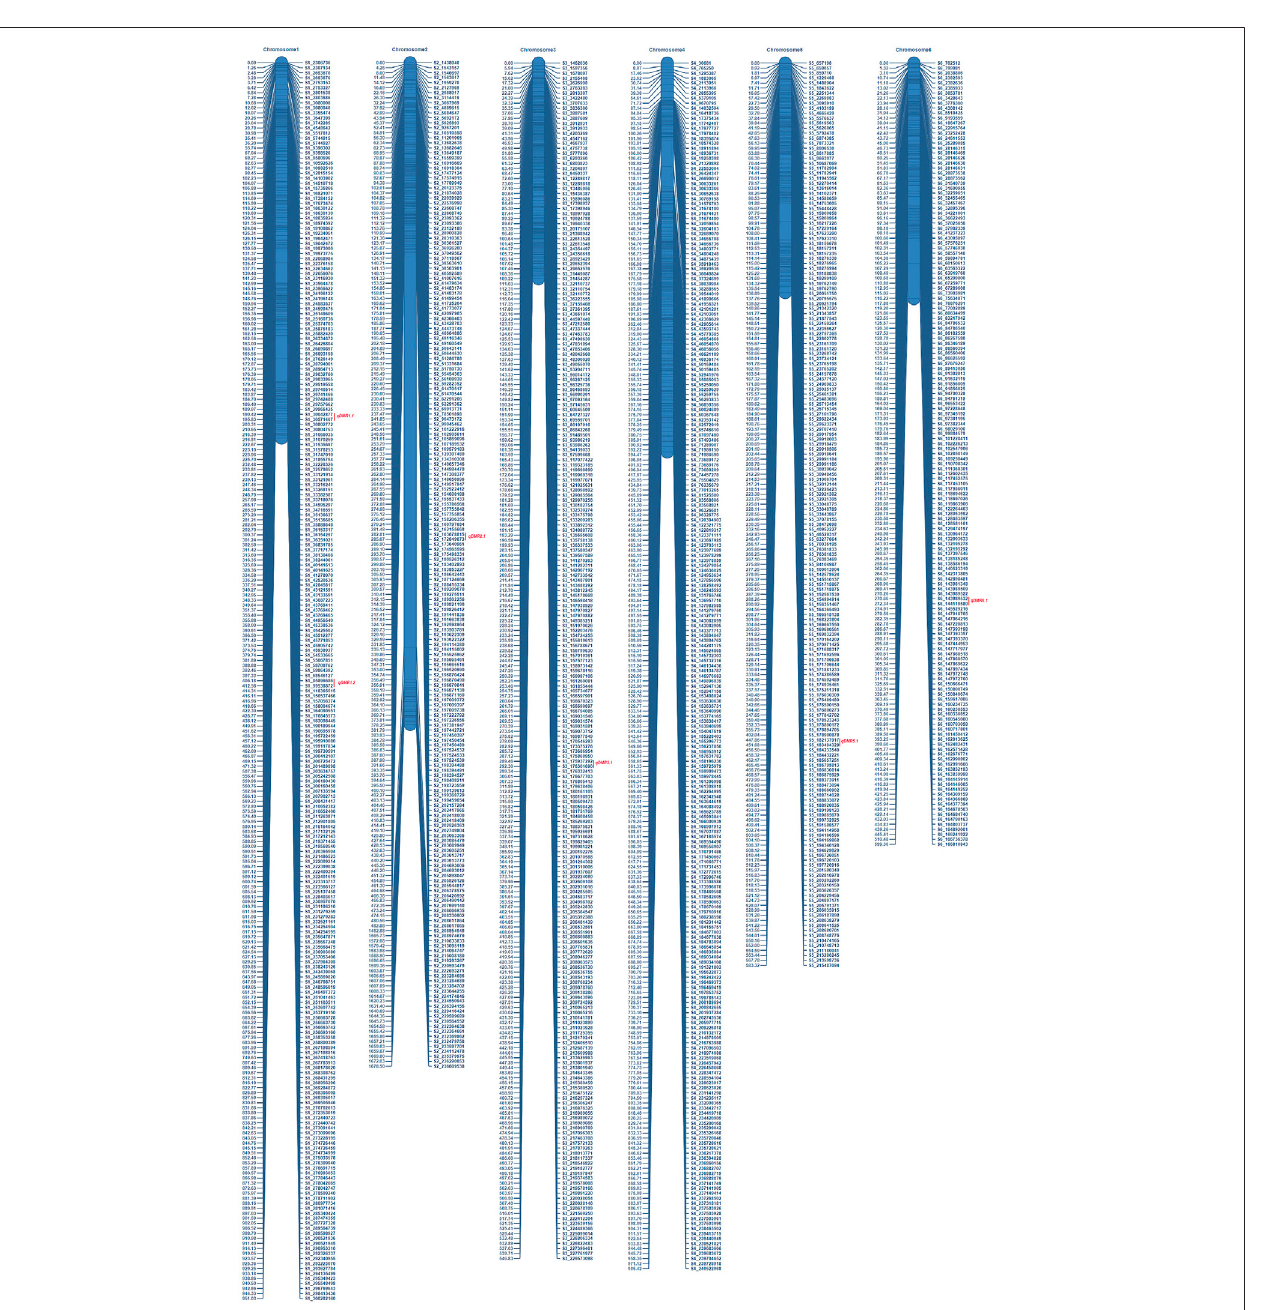
Frontiers in Genetics |